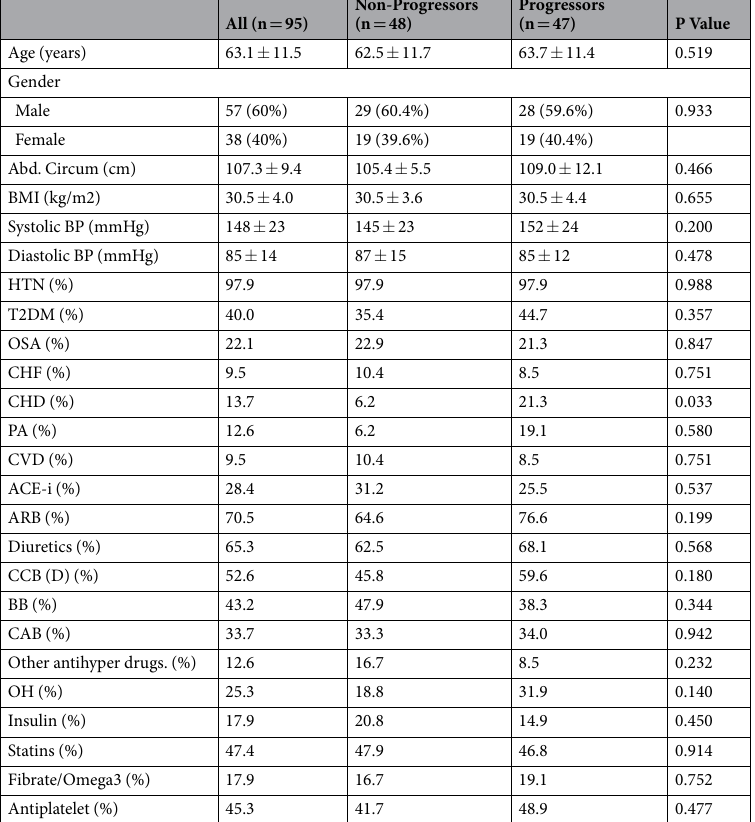
Table 1. Demographic and clinical characteristics of patients classified as progressors and non-progressors based on the decline in renal function. Mean ± SD. Progressors (decline in eGFR > 0.5 ml/min/1.73 m 2 /year) and non-progressors (decline in eGFR < 0.5 ml/min/1.73 m 2 /year). Abbreviations: Abd. Circum: